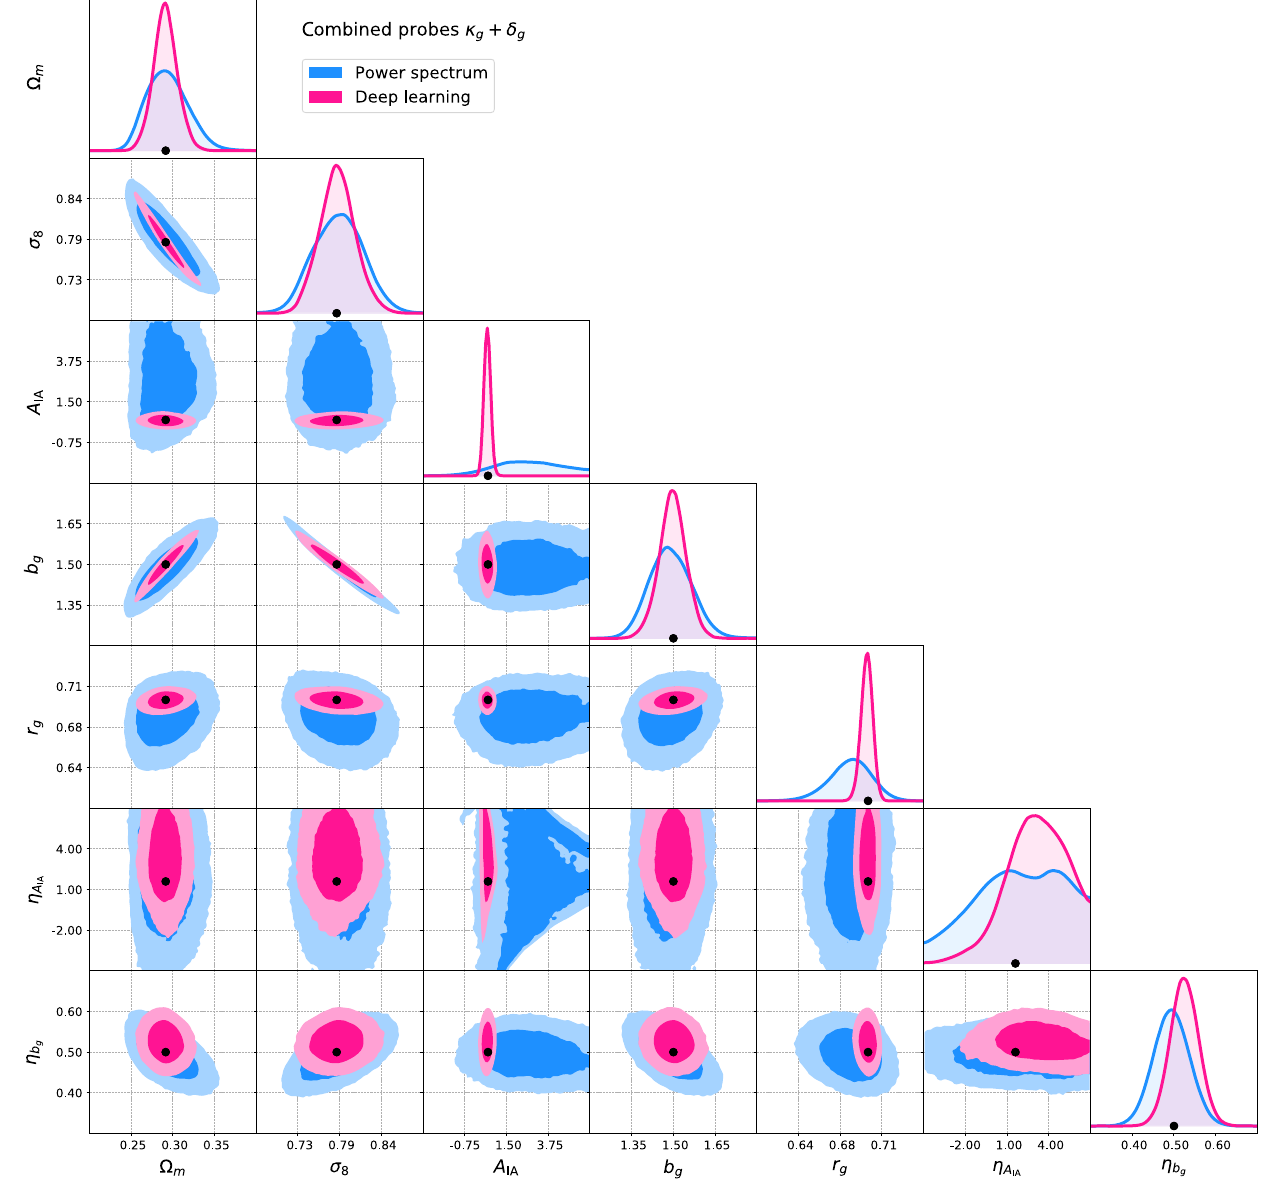
FIG. 2. Constraints for combined probes with deep learning (pink), compared to power spectra (blue), for the main model with linear galaxy bias. The black dots mark the true value of parameters used here, from the fiducial model summarized in Table I. The mock observation used here was taken as the most likely model prediction for the fiducial